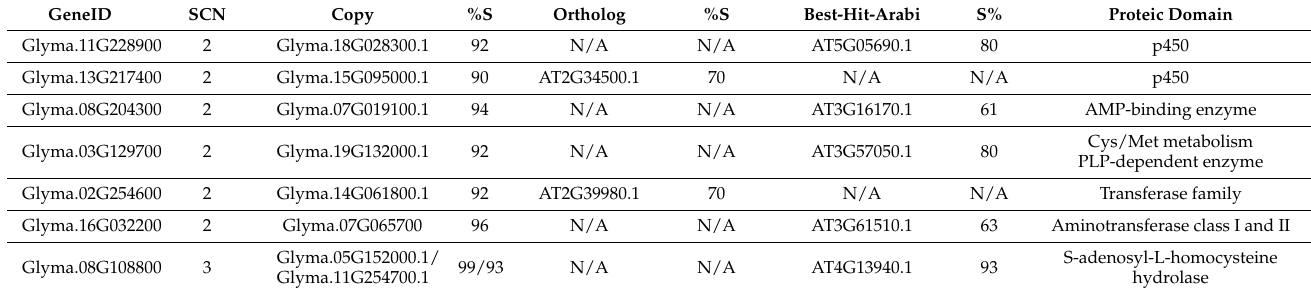
Table 2. Evaluation of copy number, orthologs, and protein domains between soybeans and Arabidopsis .